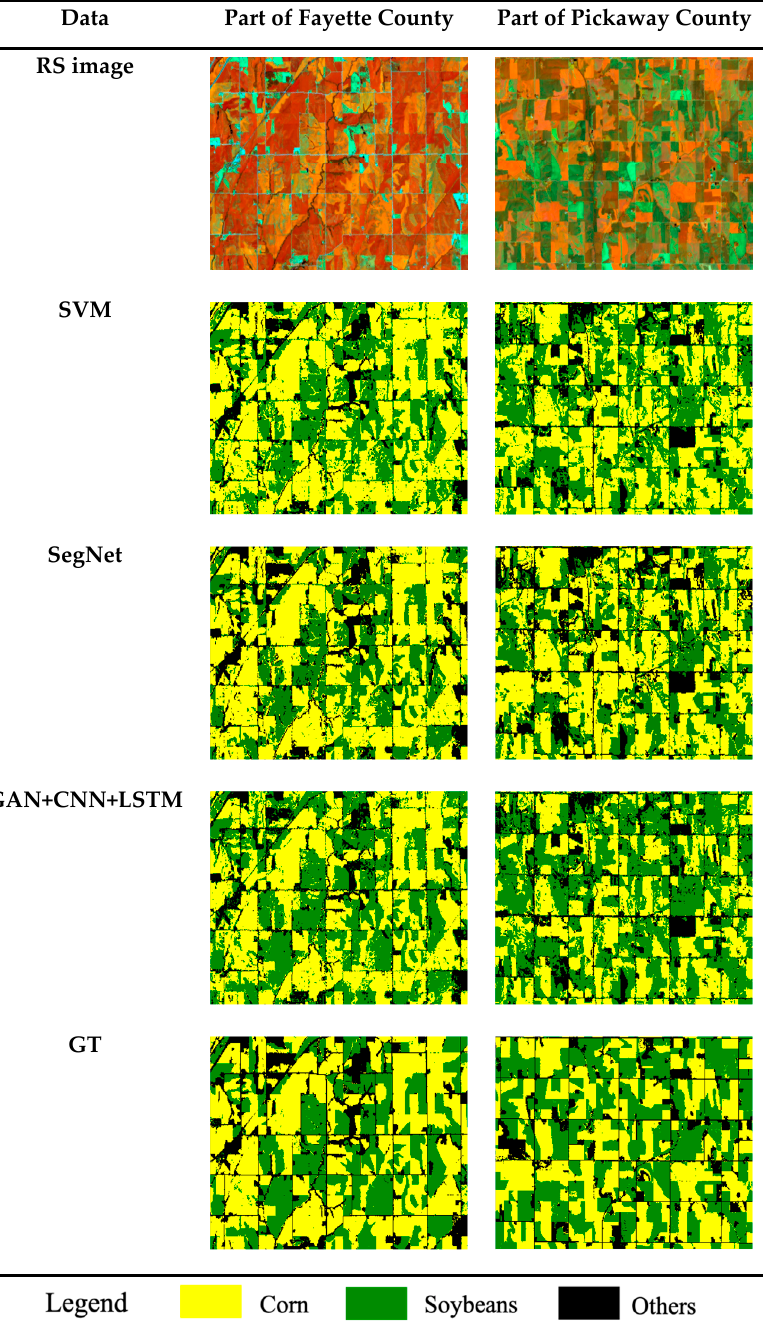
Figure 9. Visualization of the prediction results of the model in Fayette County and Pickaway County.